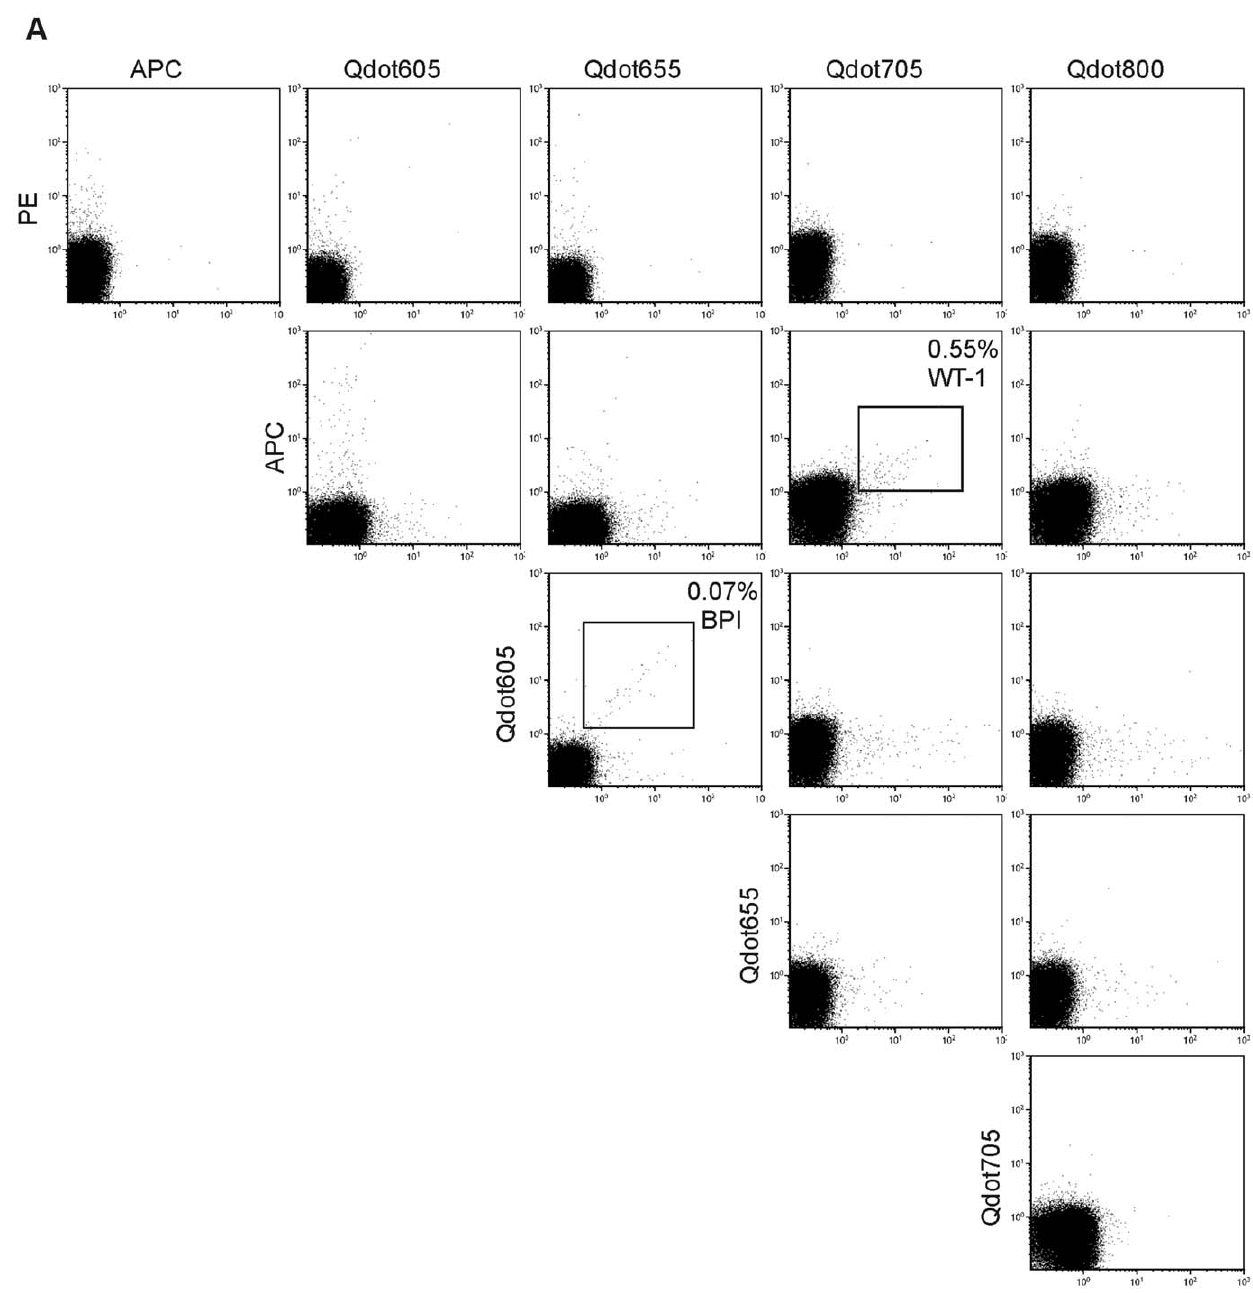
Figure 5. Detection of multiple peptide-specific CD8 + T cells after enrichment of patient PBMC. Fifteen different dot plots showing multimer-enriched PBMC of representative patient UPN665 stained with the combinatorial encoded MiHA assay using the multimers of pool A. Epitope-specific T cells were detected for RMFPNAPYL (APC and Qdot705) and KLQPYFQTL (Qdot605 and Qdot655). In addition to double positive cells, single positive cells for either APC, Qdot605, Qdot655 or Qdot705 are visible in their respective channels. Cells were stained with multimers, CD8 AlexaFluor 700, CD4-, CD14-, CD16- and CD19-FITC and Sytox Blue. Subsequently, cell populations were analyzed by flow cytometry. Cells were gated on CD8 + FITC 2 Sytox Blue 2 lymphocytes and corrected for single, triple, quadruple or quintuple multimer positive cells. The percentage of tetramer + CD8 + T cells is depicted in the dot plots. doi:10.1371/journal.pone.0021266.g005 dual-color coded CD8 + T cells, PBMC were cultured in IMDM 10% HS and stimulated with irradiated EBV-LCL expressing the Table S1 Screening pool of high and intermediate binding appropriate HLA restriction molecule. After initial stimulation, HLA-A2 peptides set up with combinations of labeled MHC 100 IU/ml IL-2 (Chiron) and 10 ng/ml IL-15 (BD) was added at multimers. day 2. Primary T cell cultures were analyzed by flow cytometry at day 7.